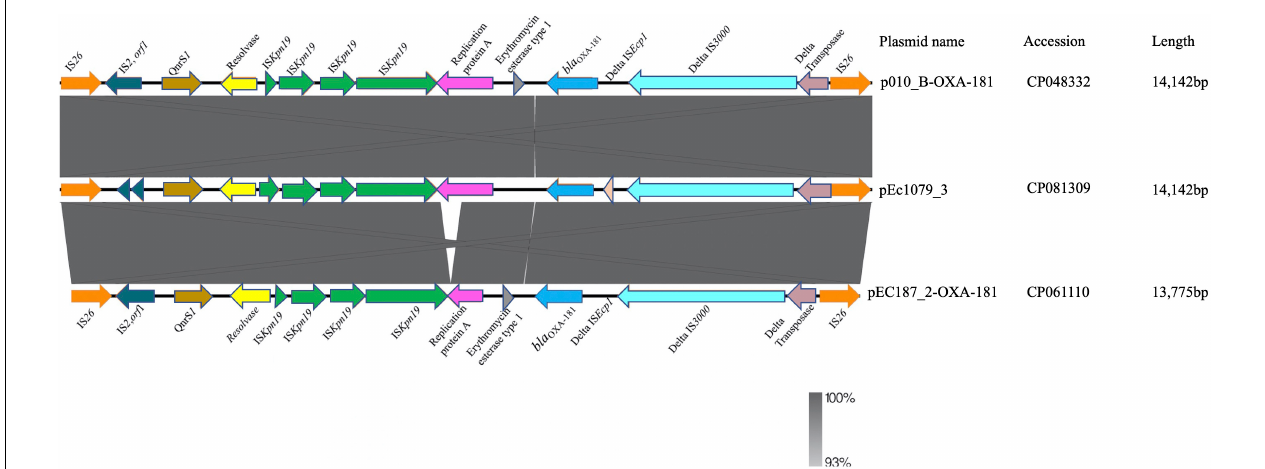
FIGURE 5 | Linear comparison of the genetic environment of bla OXA − 181 . Sequences upstream and downstream of bla OXA − 181 are shown with arrows, with the arrowheads indicating the direction of transcription. Truncated structures are indicated with denoted by “delta.” Different genes features are indicated by the different